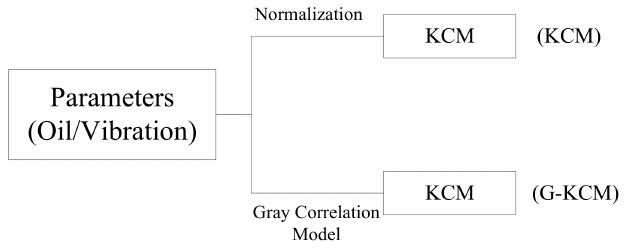
Figure 16. The specific calculation process of KCM and